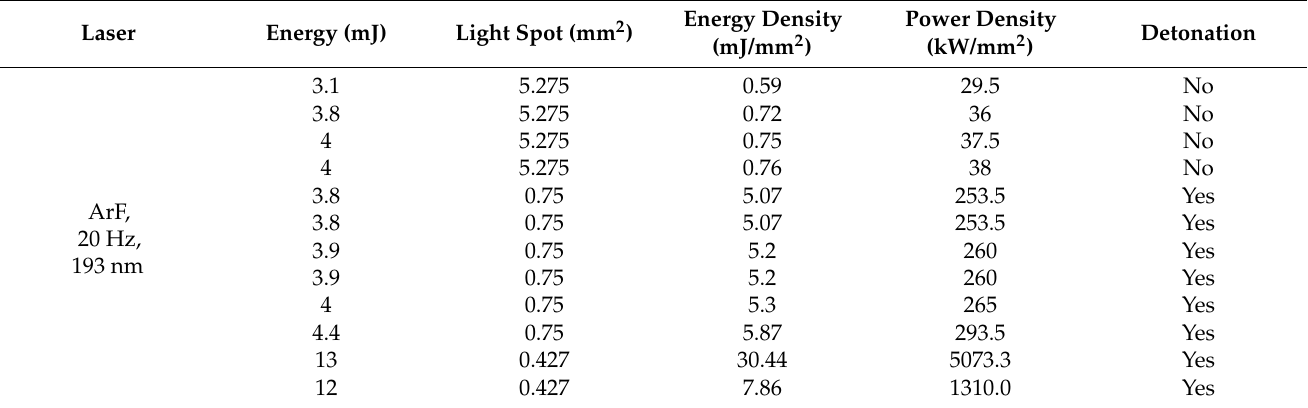
Table 4. Experimental parameter of initiation of different lasers.